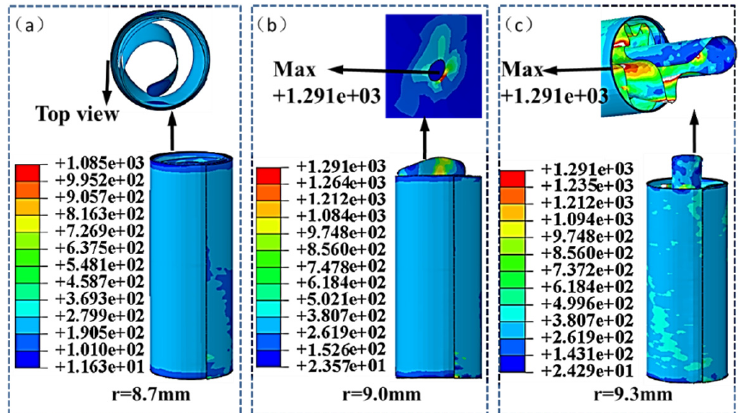
Figure 5. The stress distribution of spring reels during gathering process with top rod radius of ( a ) 8.7 mm, ( b ) 9.0 mm and ( c ) 9.3 mm.